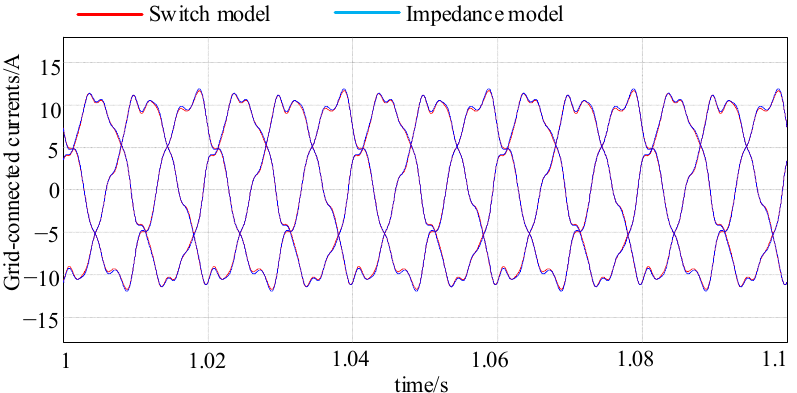
Figure 14. Simulation results of the current in the switch model and impedance model in a distorted grid.